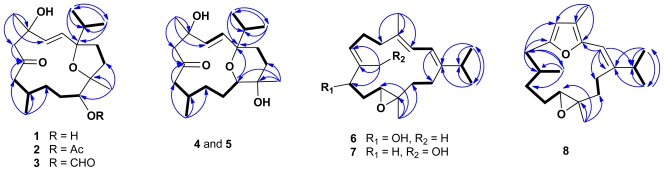
Selected 1H–1H COSY (—) and HMBC (→) correlations of 1–8.